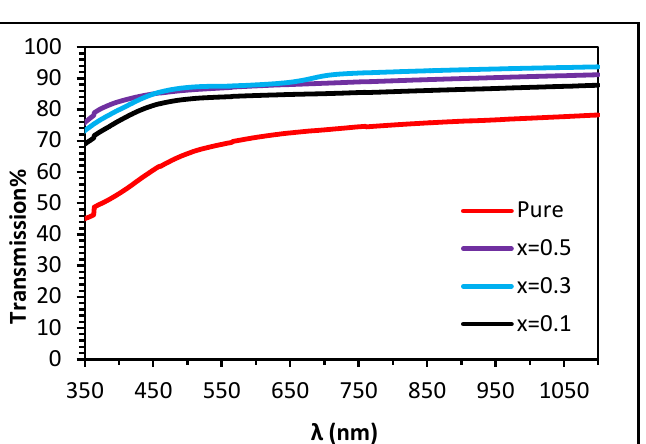
Fig. 3: Optical transmittance for V